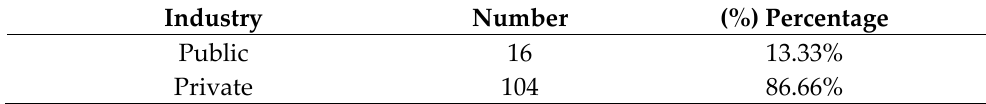
Table 4. Distribution of participants according to industry they work for.